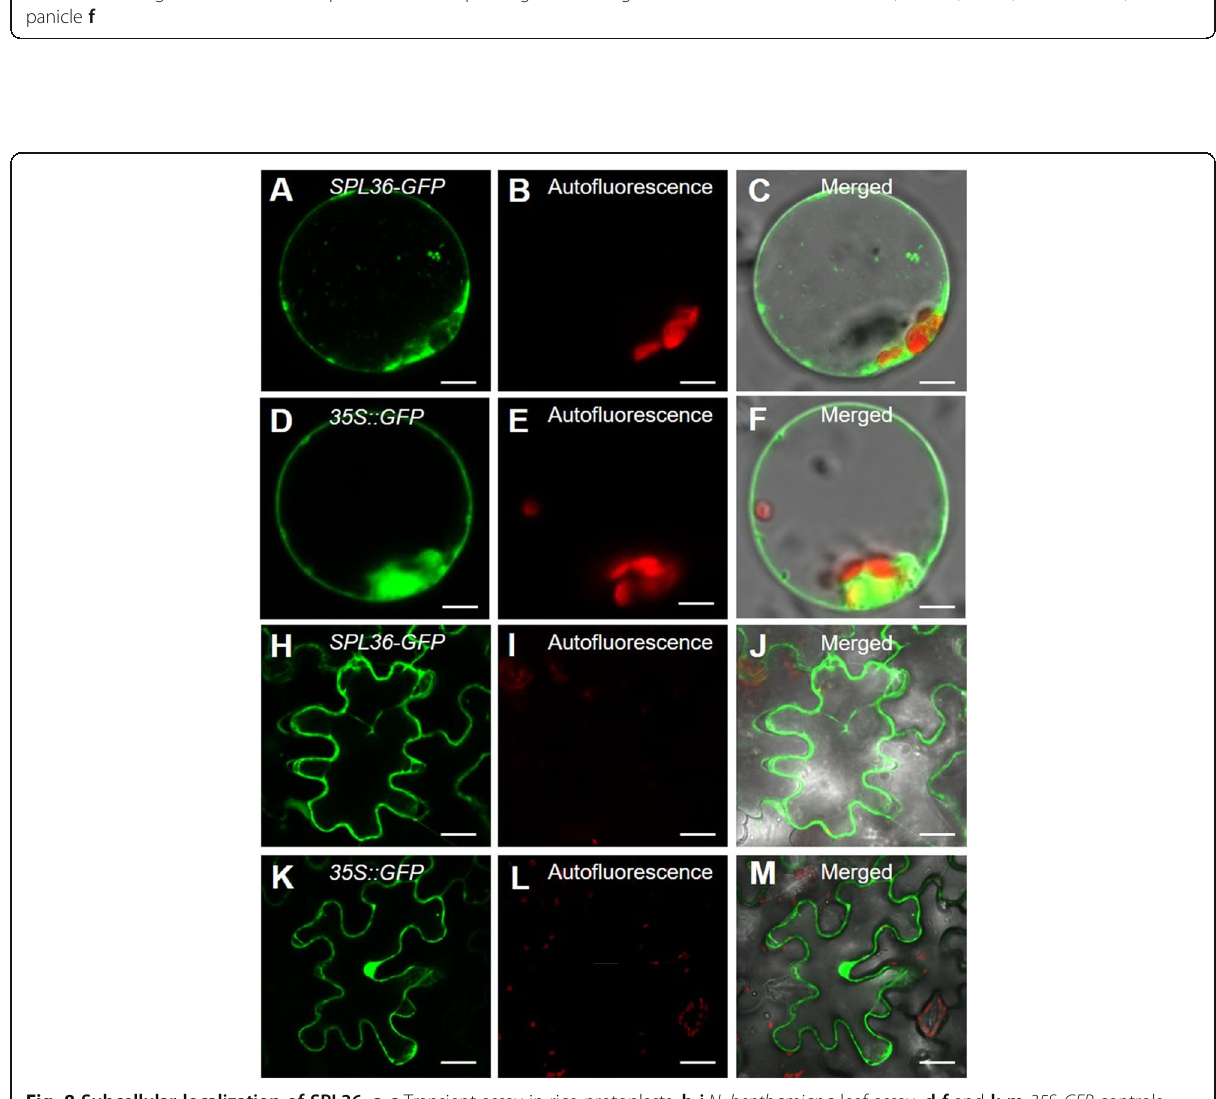
Fig. 8 Subcellular localization of SPL36. a-c Transient assay in rice protoplasts. h-j N. benthamiana leaf assay. d-f and k-m 35S::GFP controls used in the assays. SPL36-GFP : SPL36 GFP fusion protein. Bar = 20 μ